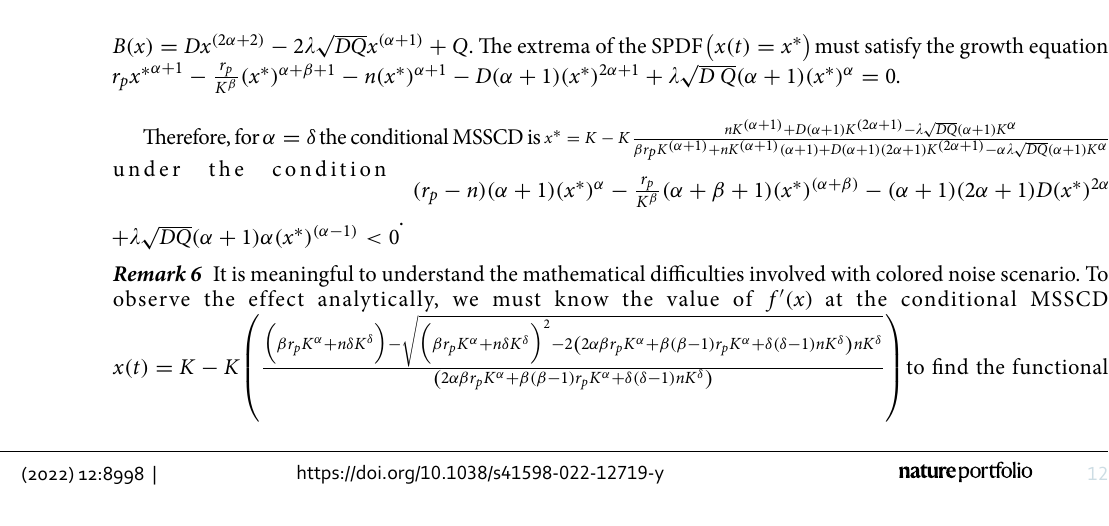
Figure 12. Distribution of cell density for r p (cid:31) 0.5 , D 0.01 , and variable correlation between multiplicative noise: ( a ) Q = = Q 0 . =